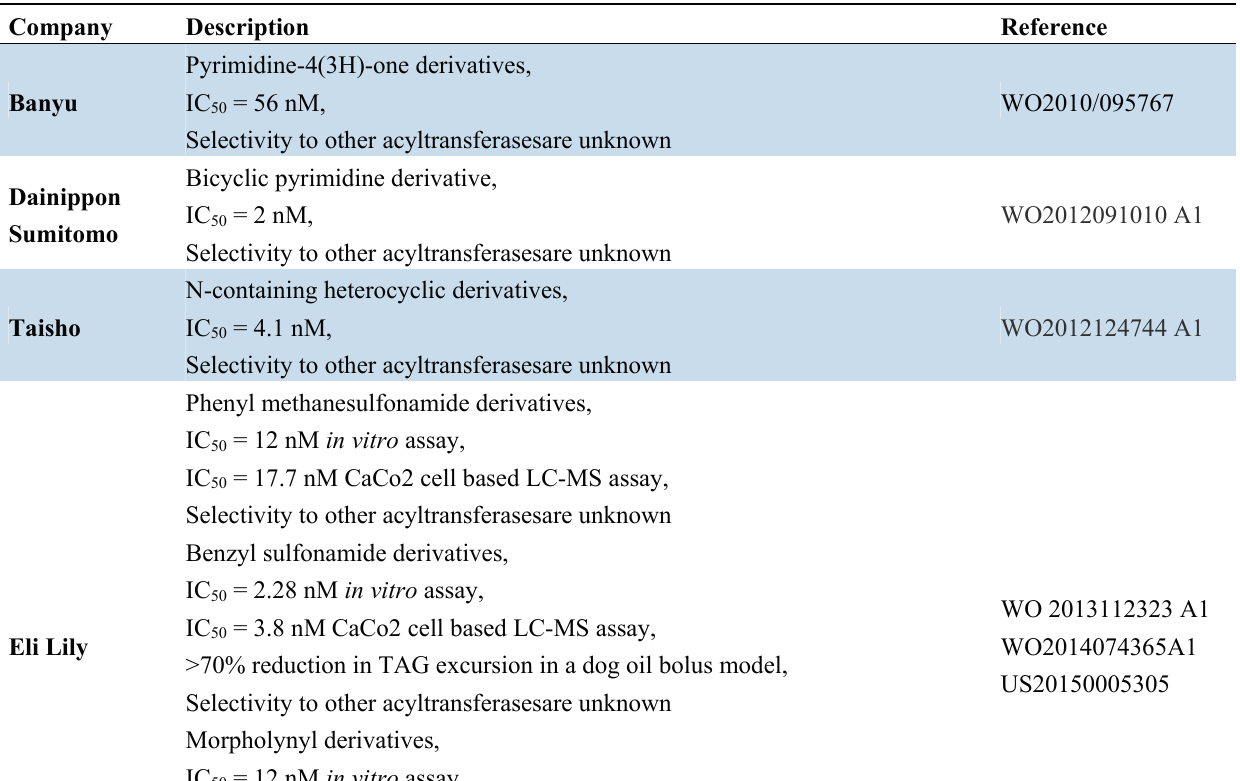
Table 2. MGAT2 inhibitors and